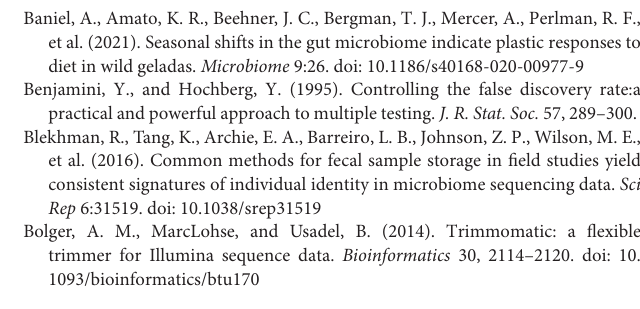
Supplementary Table 4 | List of significantly differentially abundant taxon clades and K-numbers ( A : significantly differentially abundant taxon clades; B : significantly differentially abundant K-numbers; C : significantly differentially abundant pathways) between captive and wild R. roxellana